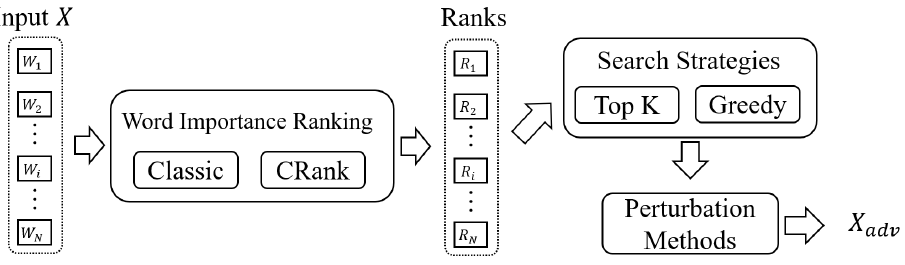
Figure 1. Overview of Our